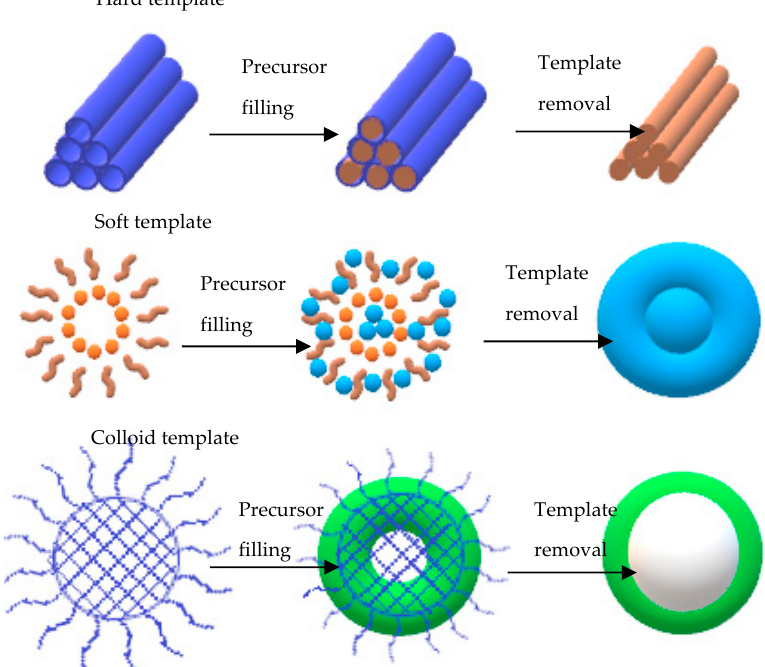
Figure 8. Schematic representation of the synthesised materials using different types of templates. Adapted with permission from [139]. Copyright Elsevier 2021.